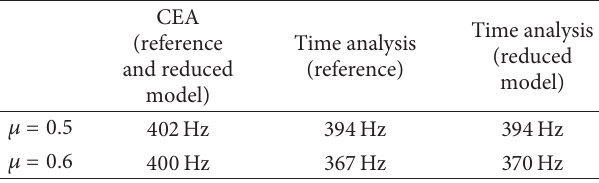
Table 2: Frequency of the unstable mode via CEA and time